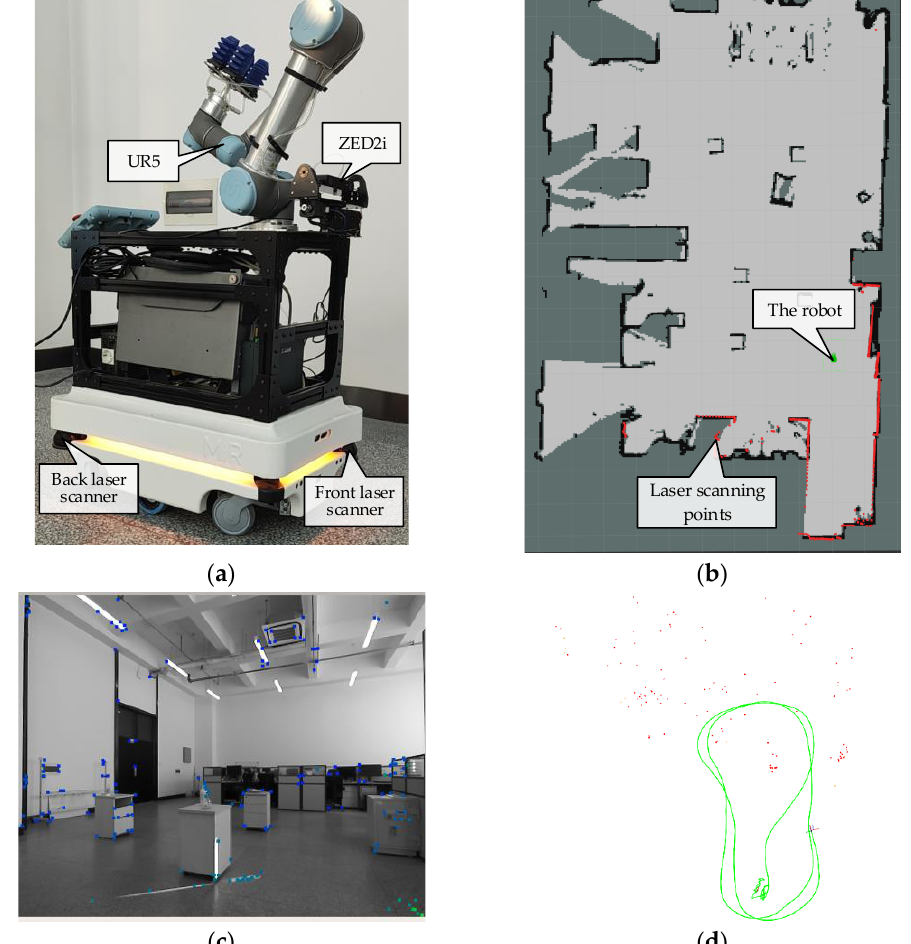
Figure 6. ( a ) The experiment platform; ( b ) localization of the robot on the established environment map; ( c ) camera view (the blue points are SLAM tracking points); ( d ) estimated trajectory of the robot (red points indicate SLAM feature points).